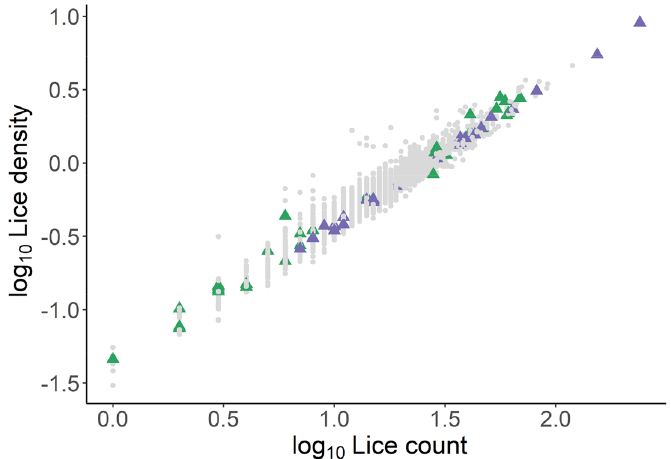
Figure 4. Linear relationship between lice count per host and lice density (count per unit surface area estimated as lice count/body weight 2/3 ) 25 across both Temp and Gen trials. Samples selected for VOC analysis are given by triangle, green denoting Gen and purple denoting